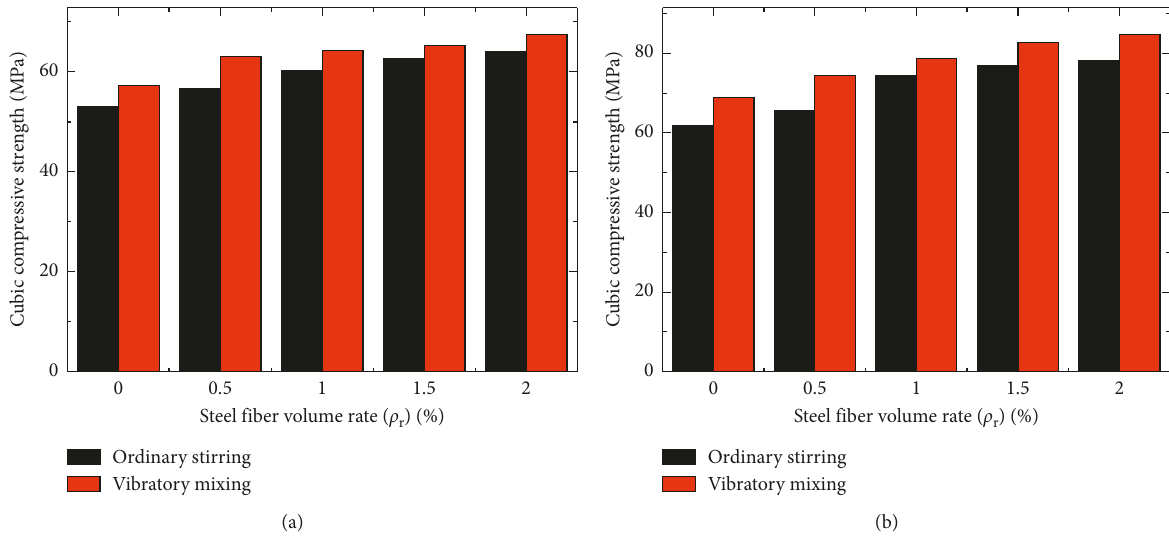
Figure 10: Effect of the mixing method on cube compressive strength of concrete. (a) CF50; (b)